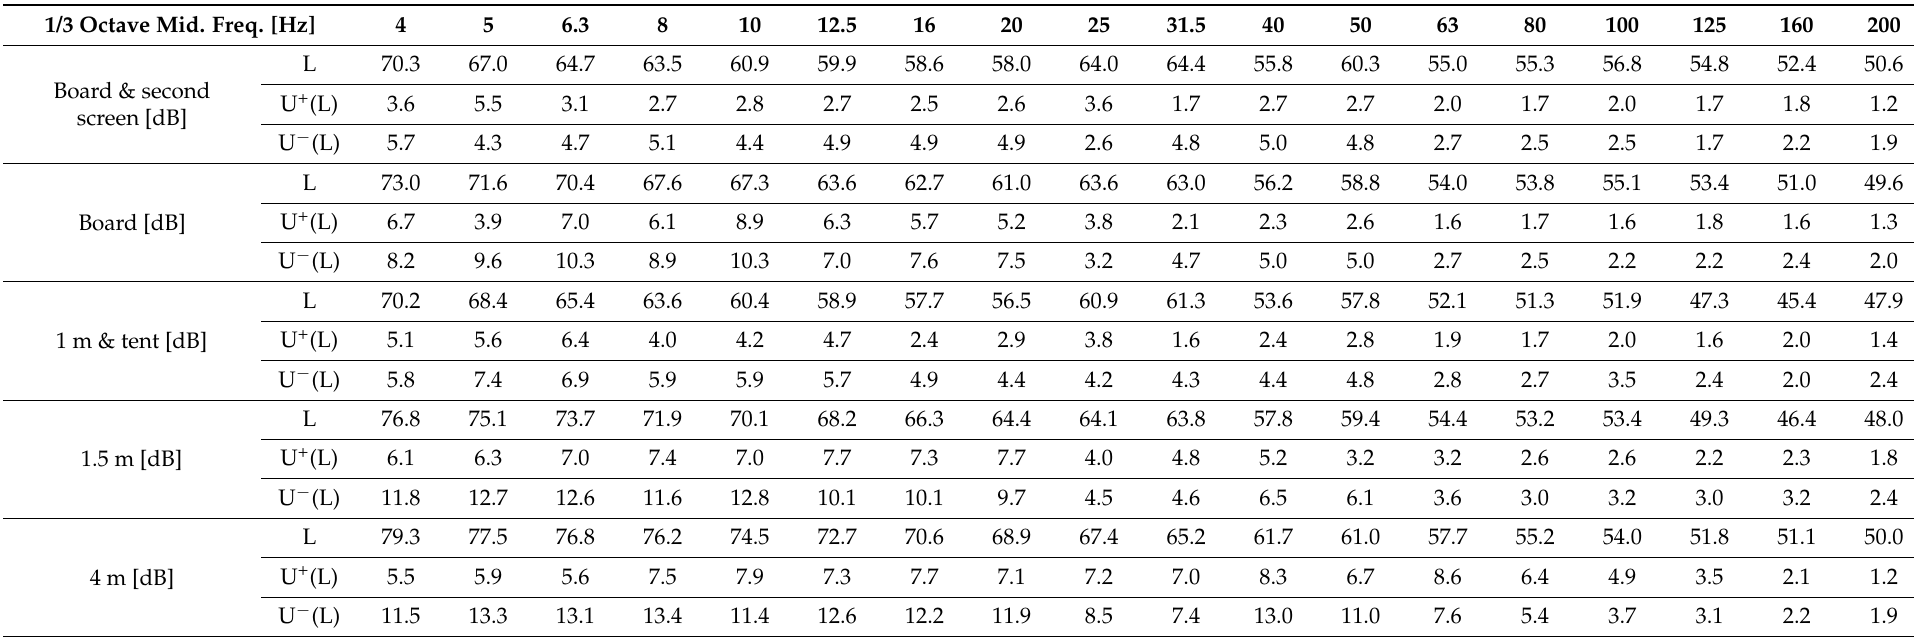
Table 5. The sound pressure level in the 1/3 octave bands and the limits of the confidence intervals for the tested measurement configurations, average wind speed–3.5 m/s, max wind speed—6.7